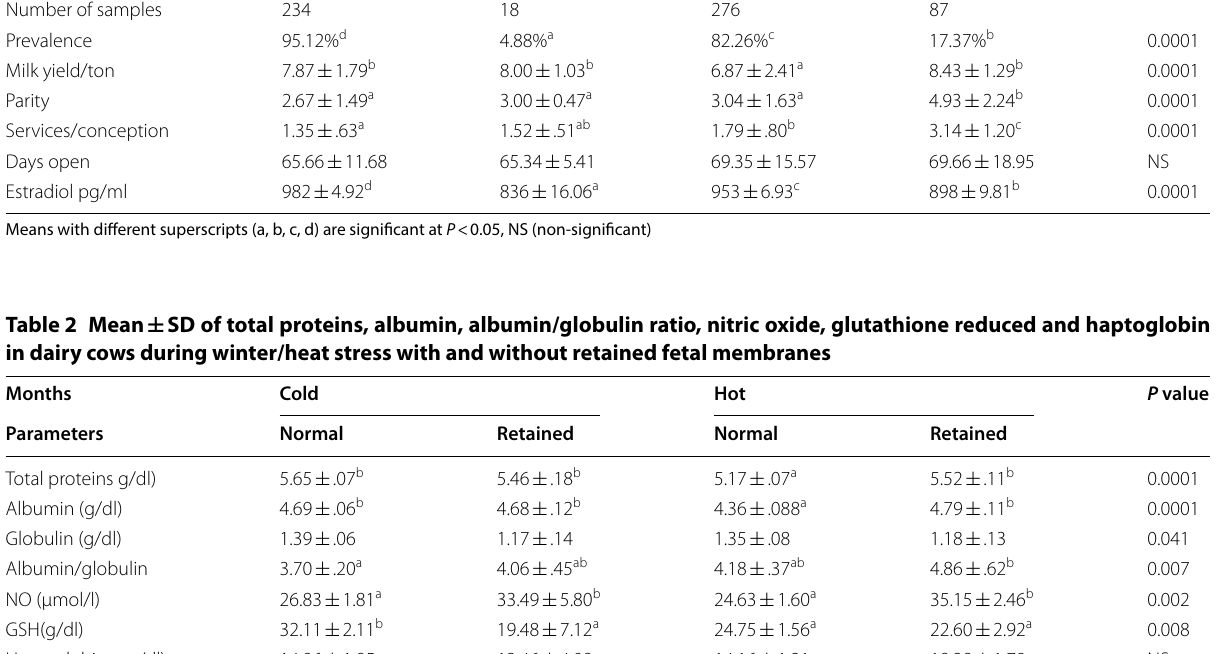
Means with different superscripts (a, b, c) are significant at P < 0.05, NS (non‑significant), NO (nitric oxide), GSH (glutathione